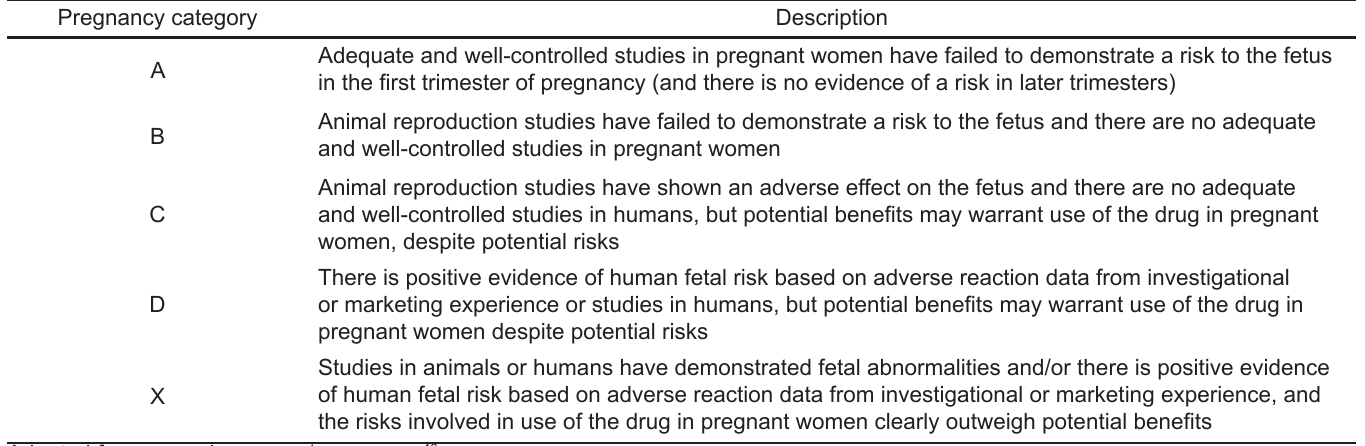
Table 3. U.S. Food and Drug Administration pregnancy